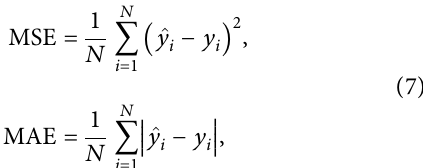
Table 3: Comparison experiments by adding decay-scale random noise with diverse scales to the high-frequency subseries and the original time series.